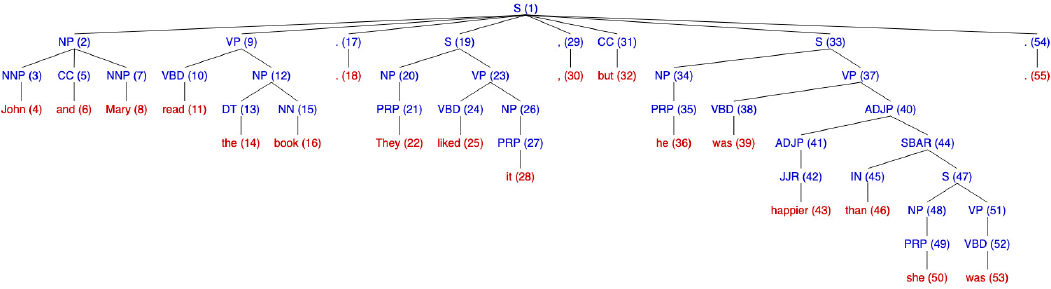
Figure 4. Sample text for gender and number